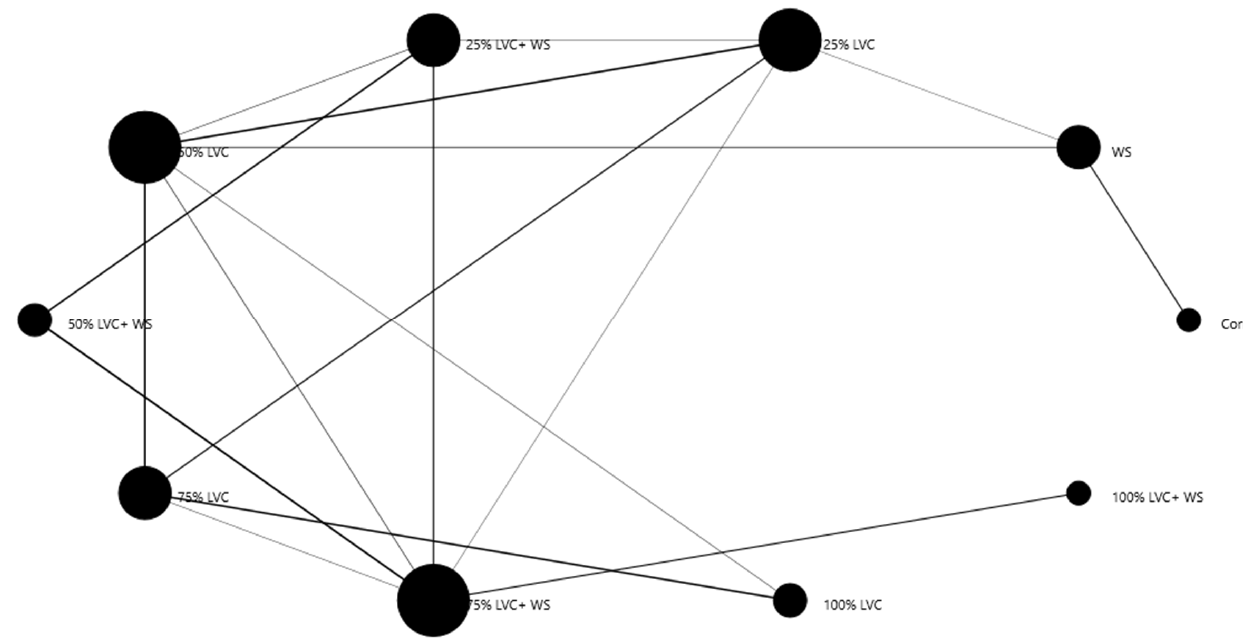
Figure 8. Network plot analysis of essential oil compounds corresponding to the treatments.